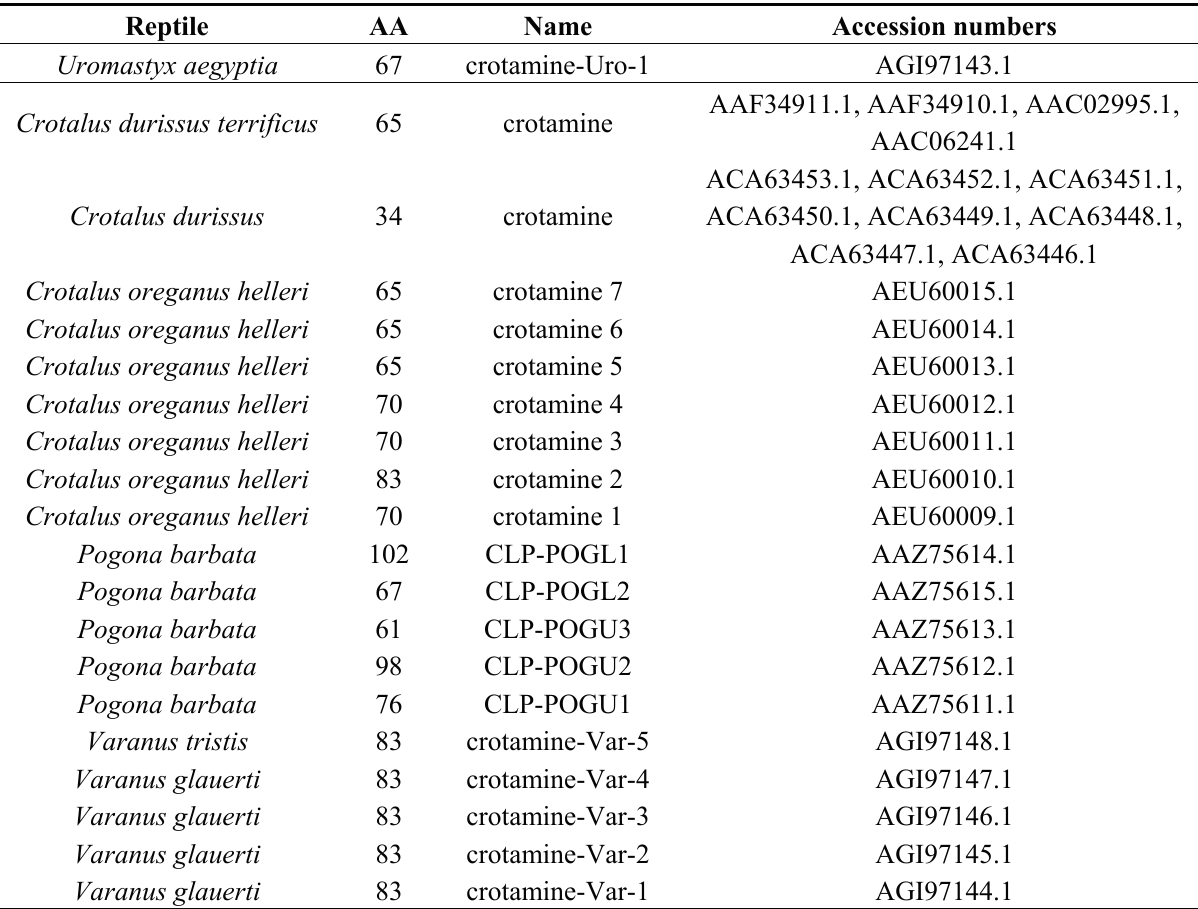
Table 9. Crotamine-like peptide genes in